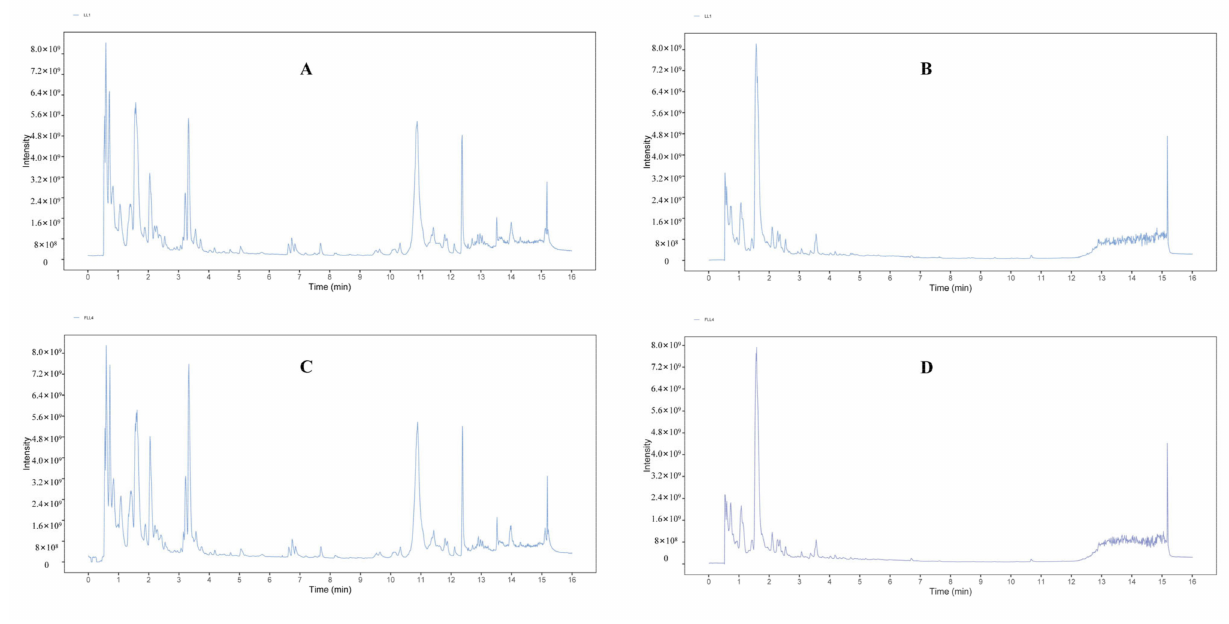
Figure 1. Total ion current diagram of random single samples of LL and FLL. ( A ) Positive-ion mode analysis of LL, ( B ) negative-ion mode analysis of LL, ( C ) positive-ion mode analysis of FLL, and ( D ) negative-ion mode analysis of